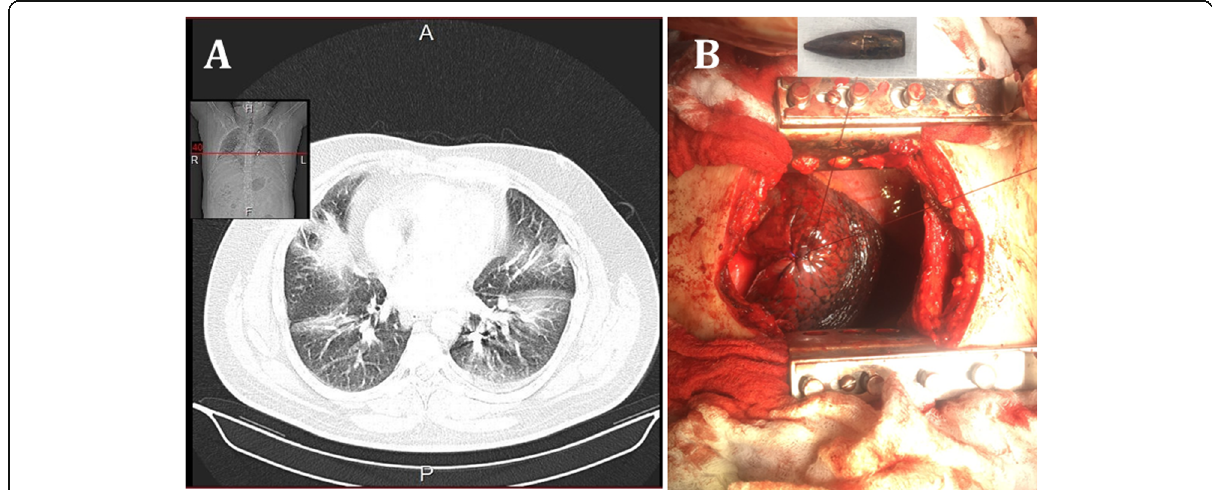
Fig. 2 a CT scan of chest (pulmonary window) showing the bullet in left lower pulmonary lobe. b Left thoracotomy for bullet extraction from left lower pulmonary